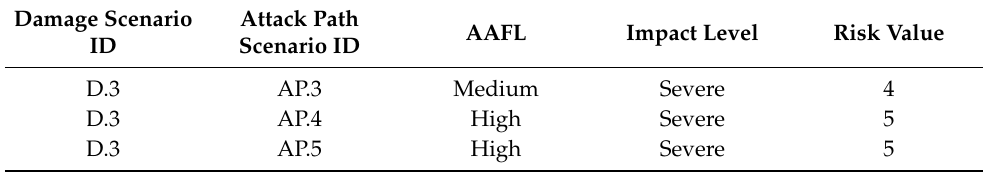
Table 7. Final risk determination related to